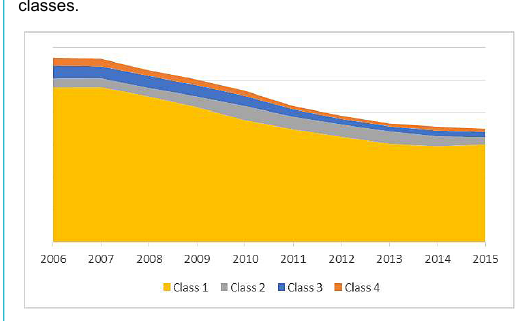
Figure 5: Evolution over time of the different home visit cluster